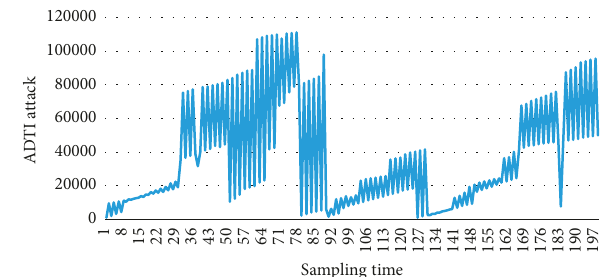
Figure 15: Feature of VPI for attack traffics.